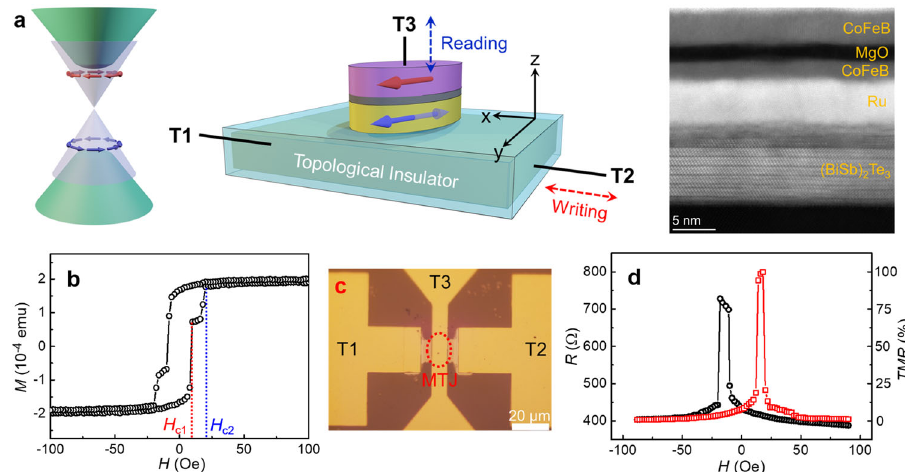
Fig. 1 Schematic of the TI-driven SOT-MRAM cell. a Schematic of the 3-terminal SOT-MRAM cell with a topological insulator (TI). The writing current applied between T1 and T2 is used to switch the magnetic tunnel junction (MTJ) between the parallel and antiparallel states by the spin-orbit torque (SOT), and the reading is done by the tunneling magnetoresistance (TMR) between T1 and T3. In the TI, the surface is conducting while the bulk is insulating, and the spin-momentum locking of the surface states provides a giant SOT. Cross-sectional scanning transmission electron microscopy (STEM) results show the layer-by-layer structure of the TI [(BiSb) 2 Te 3 ] and the clear interface between TI and MTJ. b The two-step switching process in the M - H curves shows the different coercive fi elds of the bottom and top CoFeB layers in the MTJ stack. c Microscopic picture of the patterned SOT-MRAM device, where the TI layer serves as the bottom electrode, and the MTJ device on top is 2 μ m × 6 μ m in size. The scale bar is 20 μ m. d Tunneling resistance R and TMR ratio as a function of the magnetic fi eld, where the 102% TMR ratio indicates the high quality of